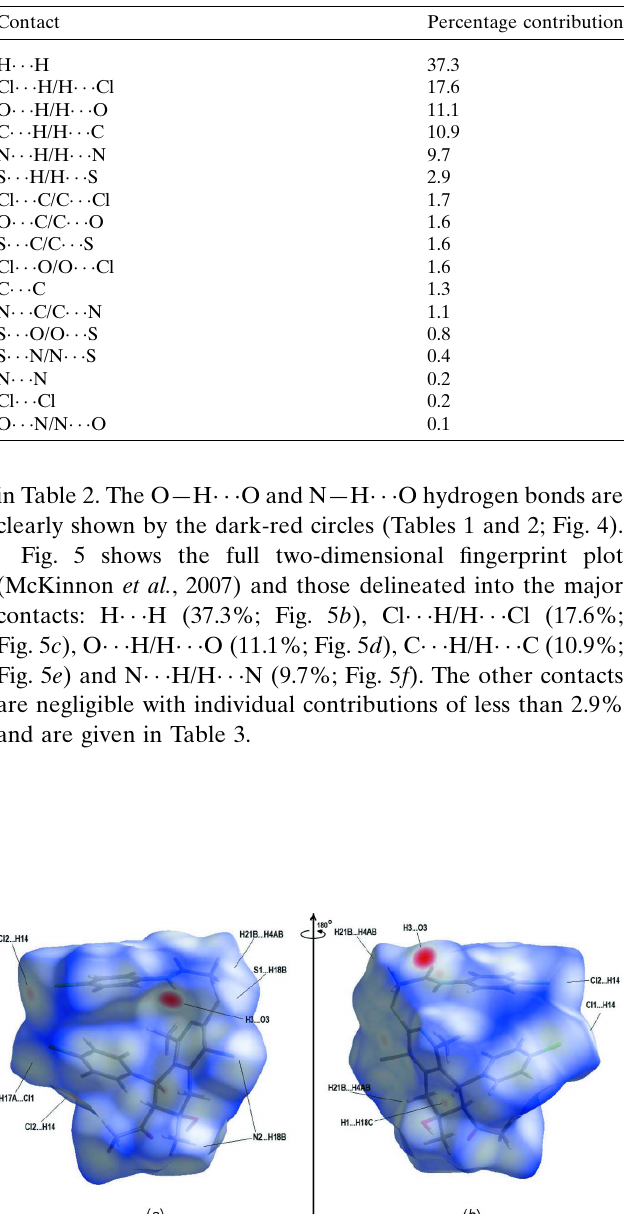
Figure 4 ( a ) Front and ( b ) back sides of the three-dimensional Hirshfeld surface of the title compound plotted over d norm in the range (cid:4) 0.3918 to +1.6138 a.u.